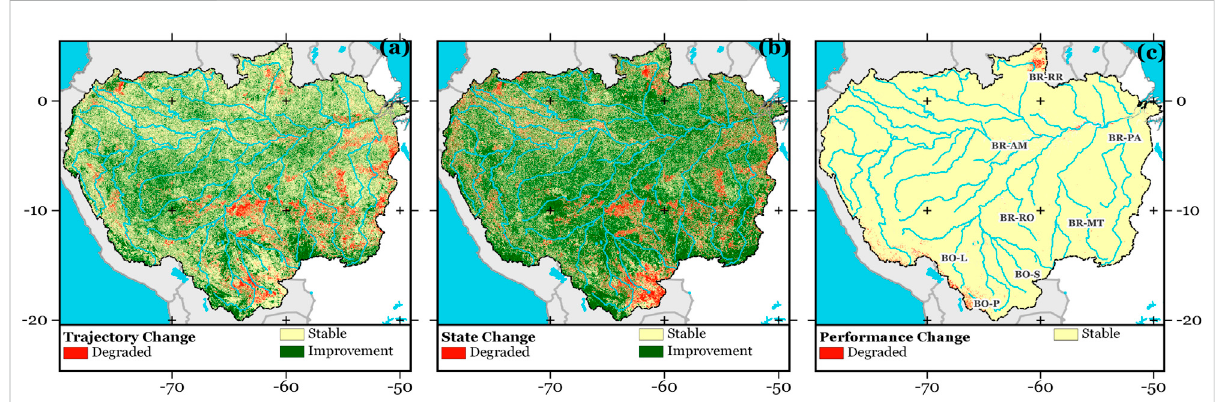
FIGURE 2 Map of the metrics (A) trajectory; (B) state; and (C) performance in the Amazon basin for the 2001 – 2020 period. The location of the Brazilian states isshown asBR-RR,Roraima; BR-AM, Amazonas; BR-PA,Pará; BR-MT,Mato Grosso; and BR-RO, Rondônia. The location oftheBolivianstates is shown as BO-L, La Paz; BO-S, Santa Cruz; and BO-P,